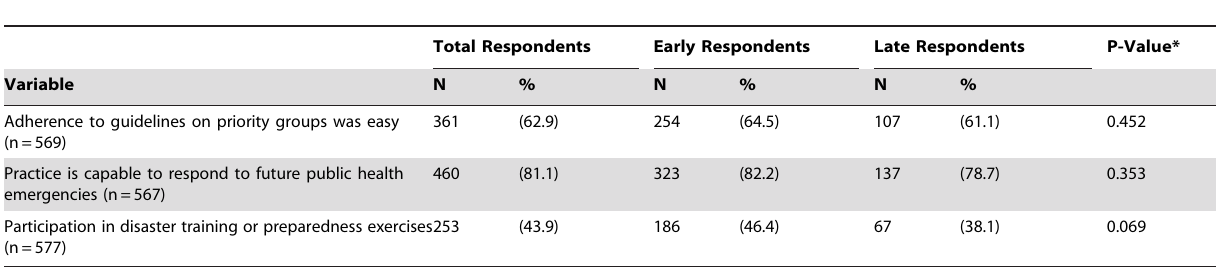
Table 3. Survey estimates by timing of